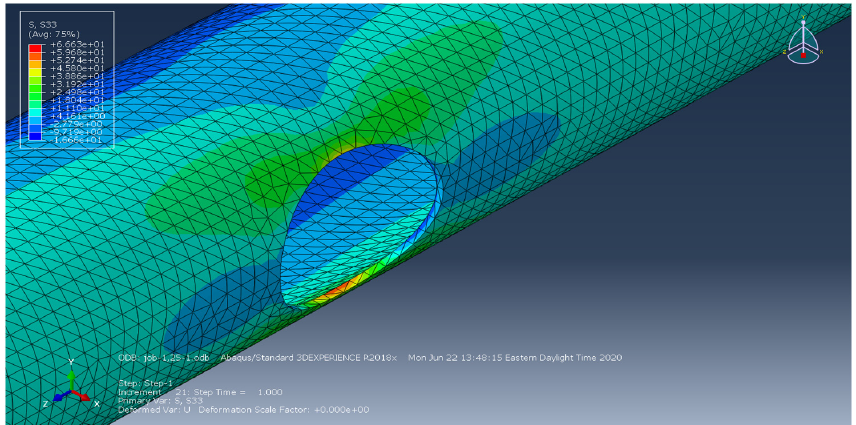
Figure 13. Aspect ratio 1.25-1 in longitudinal (Z) direction.